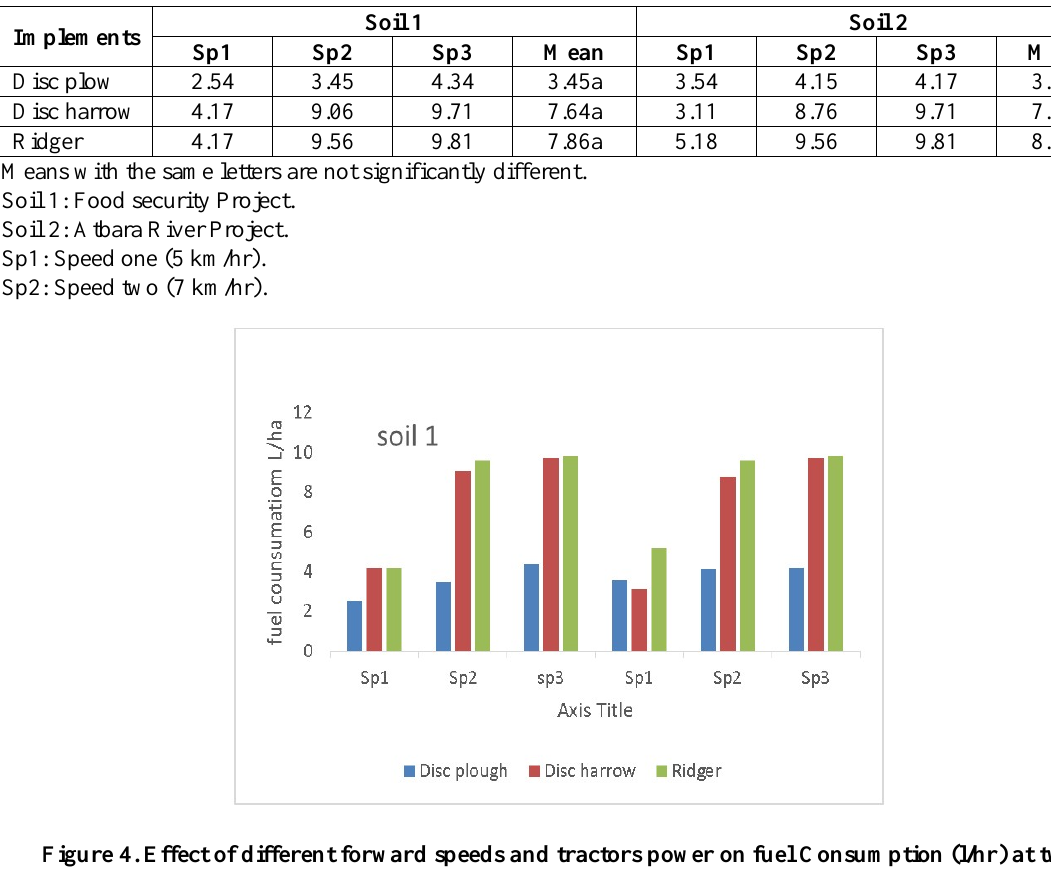
Table 7. Effect of different forward speeds on fuel Consumption (L/hr)